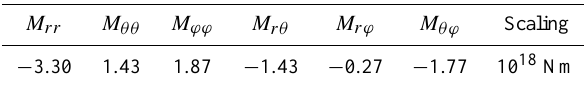
Table 3. CMT solution of the 2009 L’Aquila